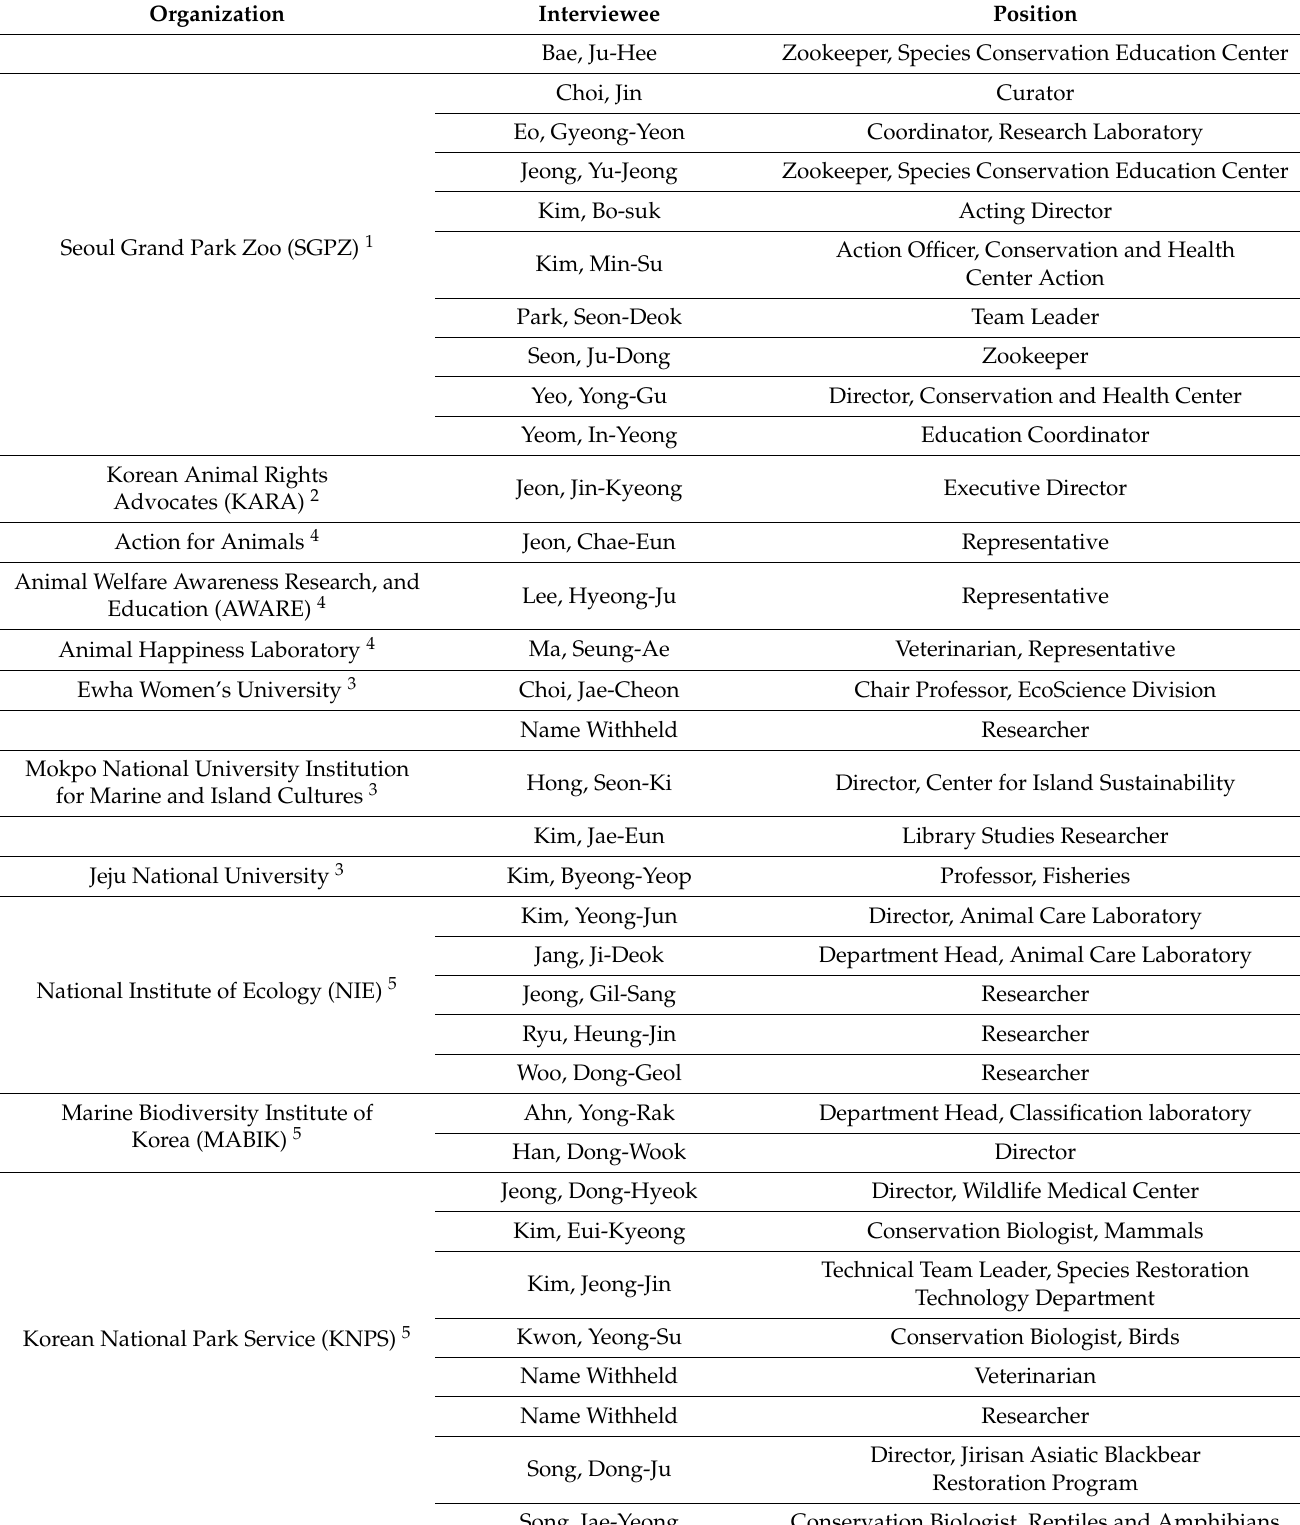
Table 2. Thirty-four interviews conducted in the Republic of Korea from June to August 2017 and from April to November